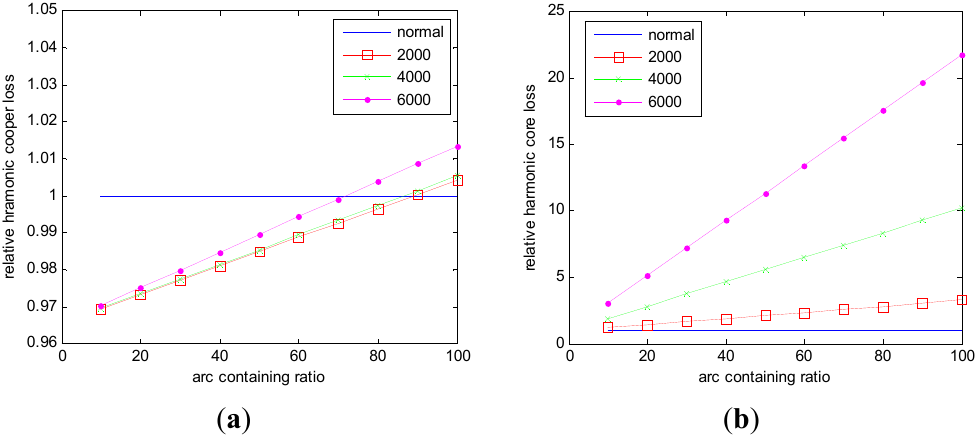
Figure 15. ( a ) Relative harmonic copper losses with different arc voltages and ( b ) Relative harmonic core losses with different arc